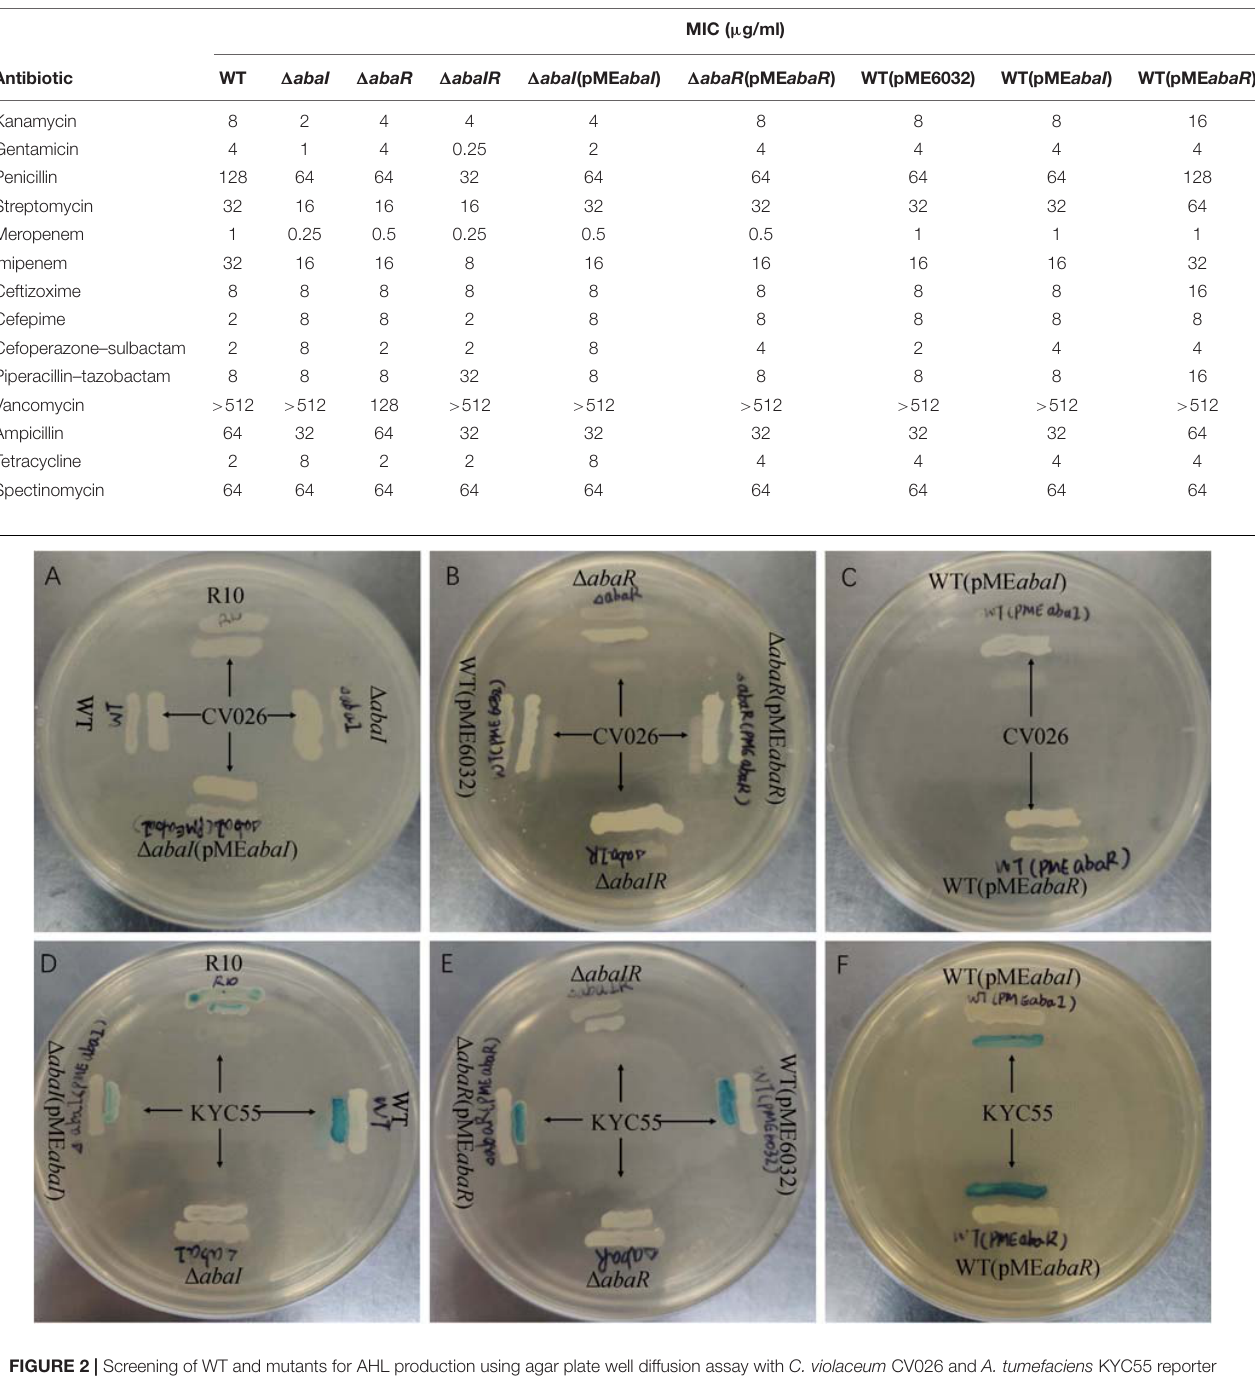
TABLE 4 | Minimum inhibitory concentrations of antibiotics used in this study.